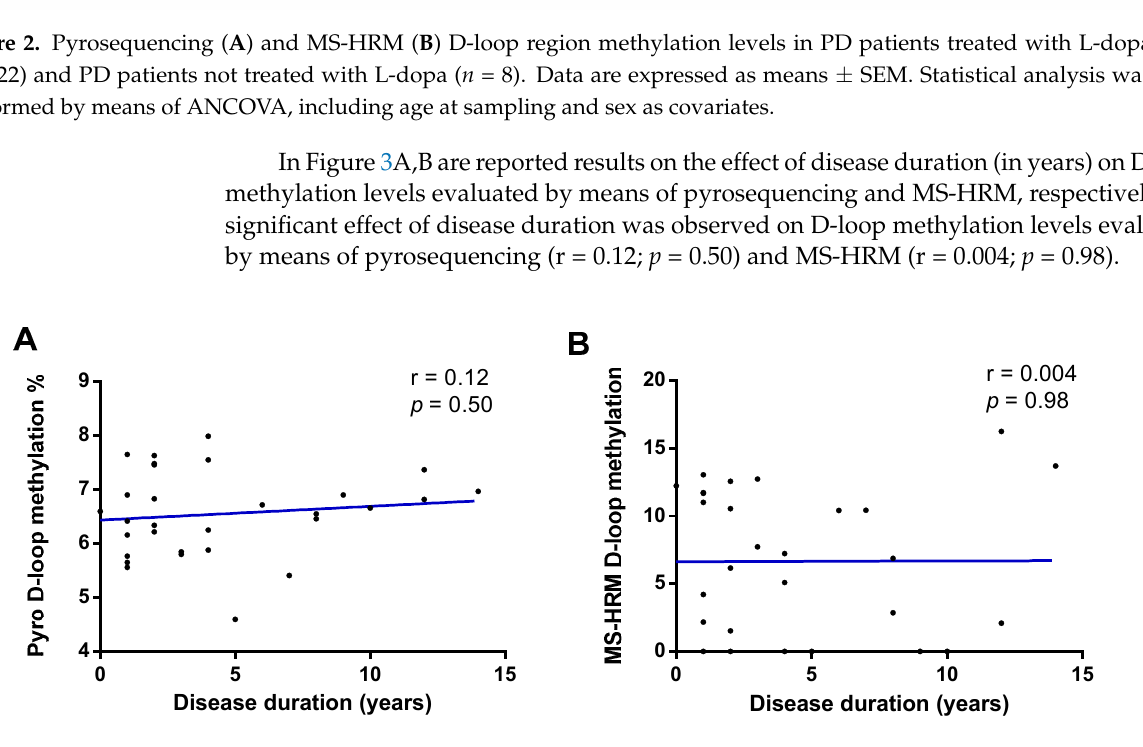
Figure 3. Correlation between disease duration (in years) and D-loop region methylation levels evaluated by means of pyrosequencing ( A ) and MS-HRM ( B ). The correlation was analyzed using Pearson’s correlation coefficient.